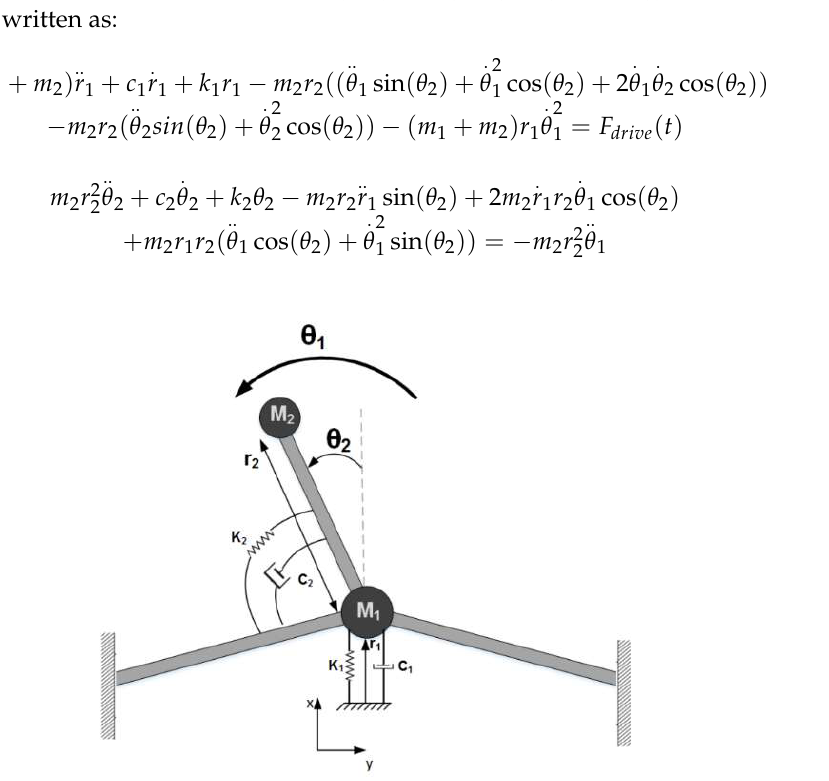
Figure 3. Lumped element representation of micro T-beam structure.